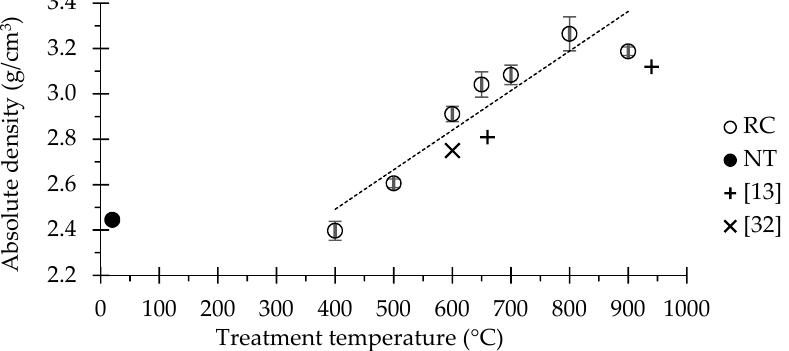
Figure 2. Measured absolute density of NT and of RC treated at different temperatures (results obtained by other authors also using helium pycnometry [14,36]).